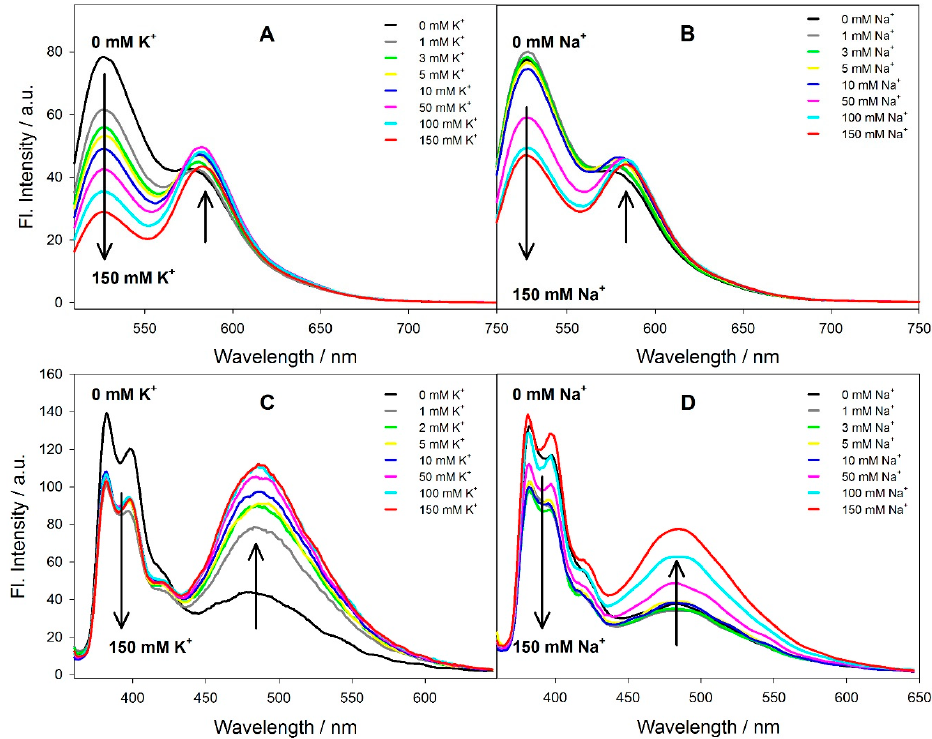
Figure 1. Potassium and sodium ions effect on the fluorescence spectra of 0.2 μ M Ch(F-TBA-T) (( A , B ), respectively) with λ ex = 490 nm, and Ch(py-TBA-py) (( C , D ), respectively) with λ ex = 340 nm. Conditions: 10 mM TEA buffer (pH 7.5), KCl and NaCl concentration: 1, 3, 5, 10, 50, 100, 150 mM.